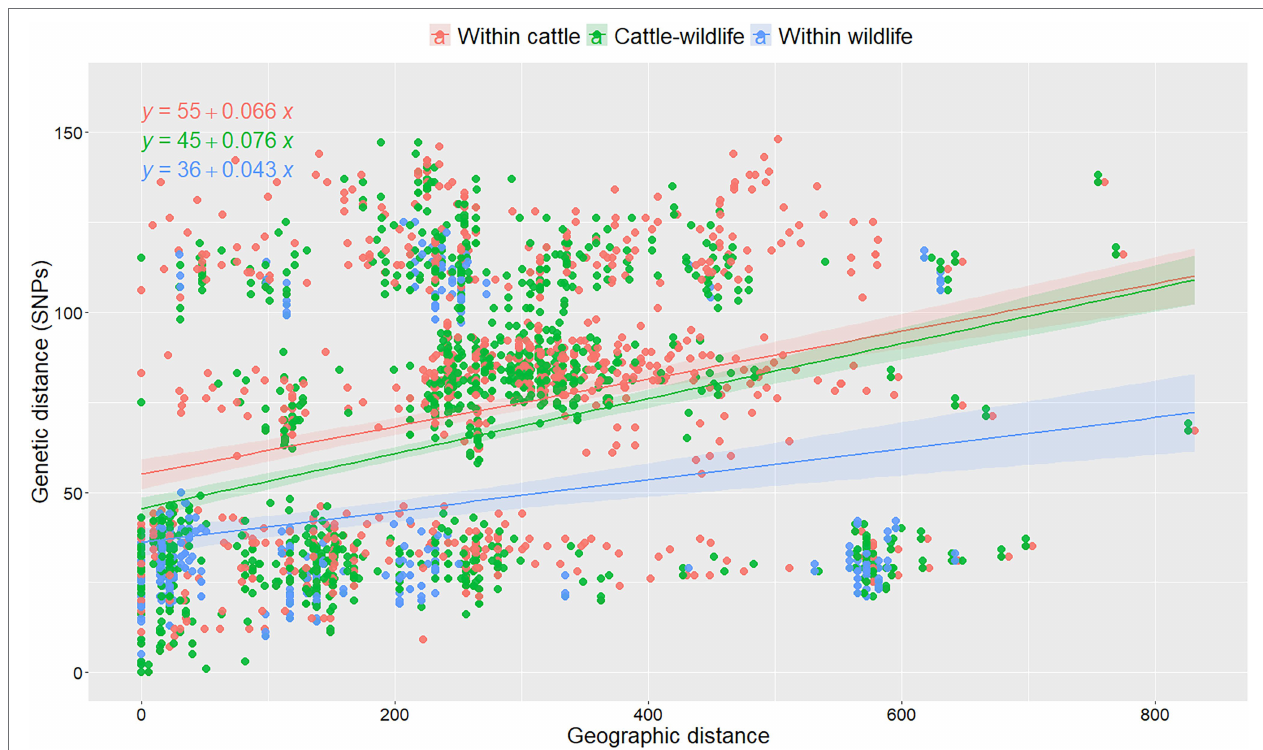
FIGURE 3 | Analysis of pairwise genetic distances between isolates recovered within- and between-species as a function of their geographic distances of isolation in one out of the 10 replicas based on random selection of one isolate per chronically infected herd. Linear regression lines were fitted to denote the relationship between genetic and geographic distances per animal species combination and formulas were depicted for each category. Colors denote different combinations of pairs of isolates retrieved from cattle (red), wildlife (green) and collected from cattle and wildlife (blue). The mathematical equations were depicted for each animal species